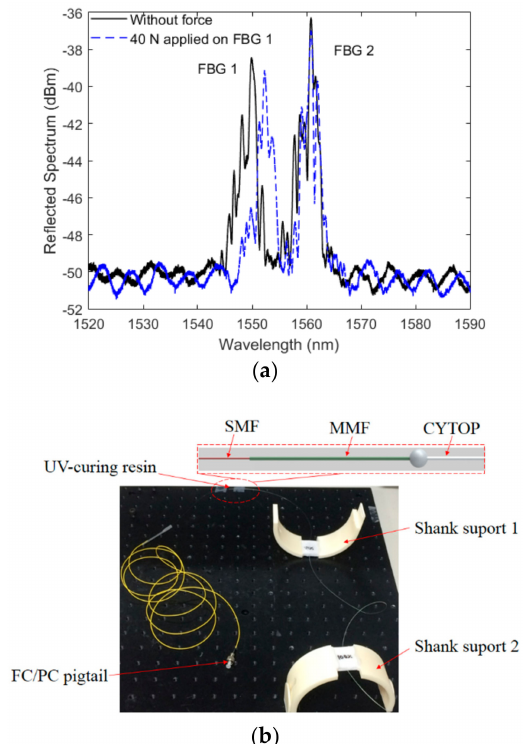
Figure 2. ( a ) Reflected spectrum of the FBG array without applied force and after a transverse force application of 40 N and ( b ) Picture of the fabricated flexible shank supports with embedded FBGs (without the elastic bands). Figure inset shows the schematic representation of the fiber-connectoriztion